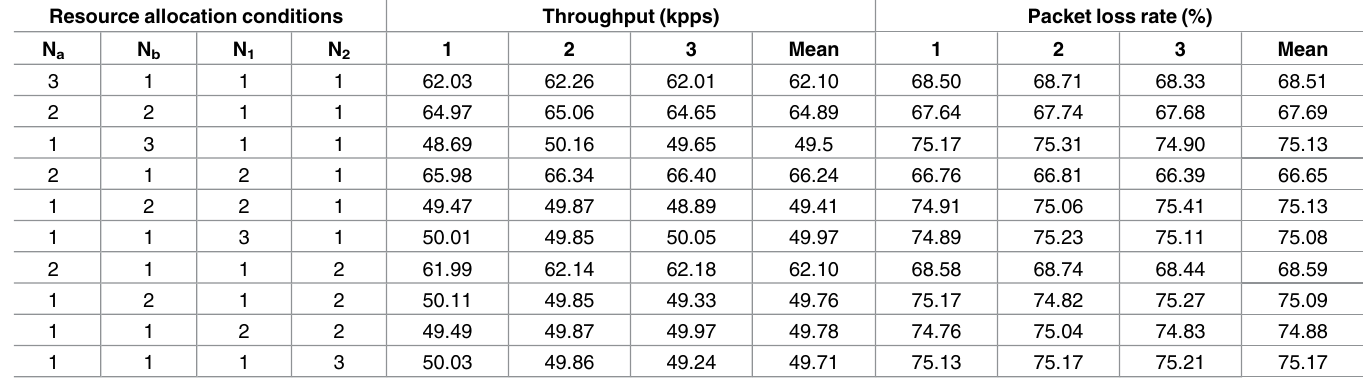
Table 1. Test results of Experiment